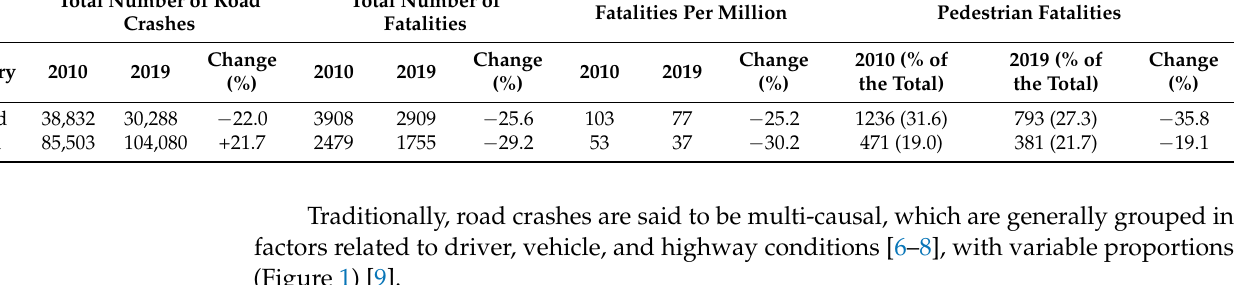
Table 1. Road safety data from Poland and Spain in 2010 and in 2019.